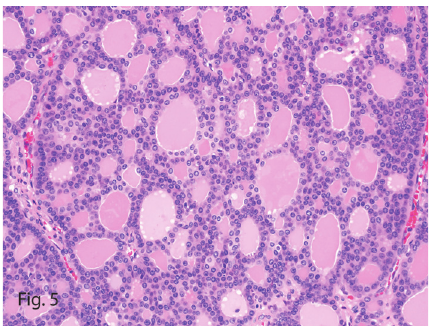
Figure 7: Cytokeratin 7 immunoexpression in the neoplastic cells (original magnification × 40).